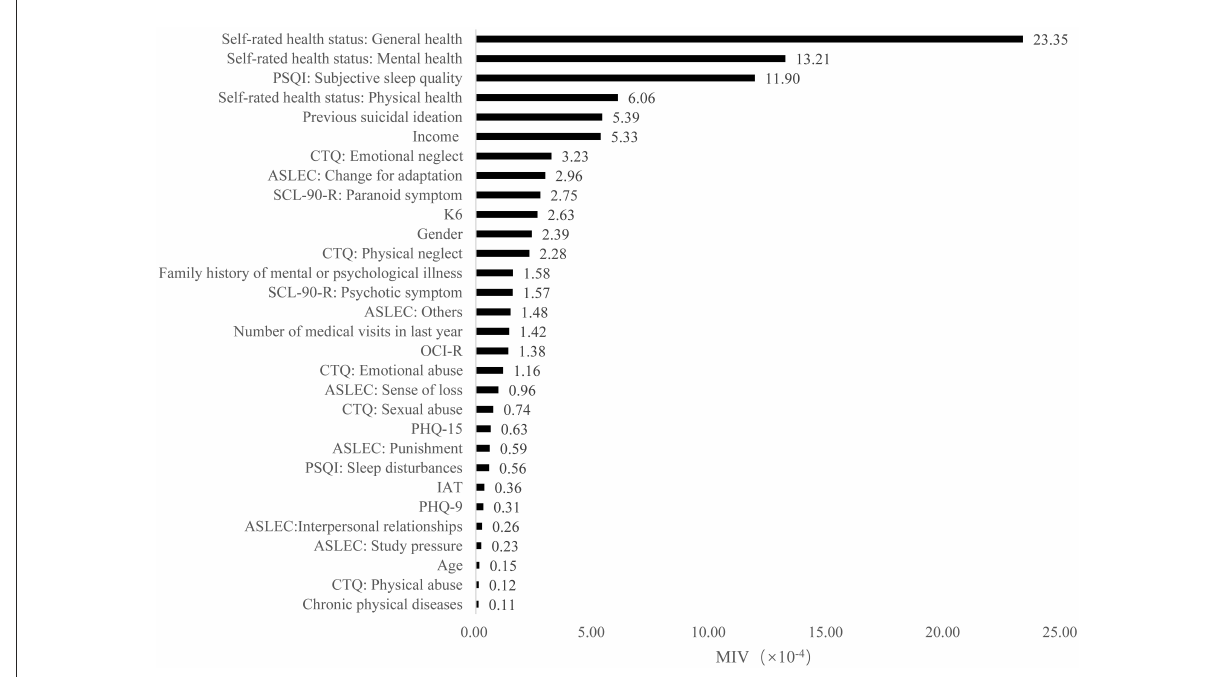
FIGURE4 The mean impact values of independent variables in model